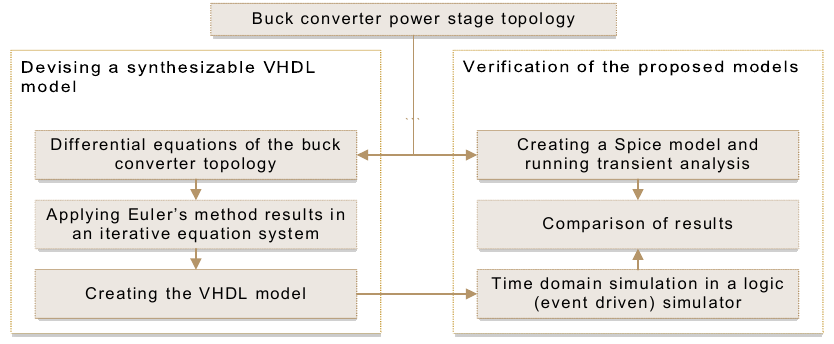
Figure 1. Synthesizable VHDL model development and validation methodology.